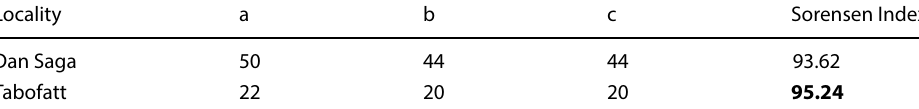
Table 3 Mean values of floristic diversity parameters, generated by the comparison test of variances per plot